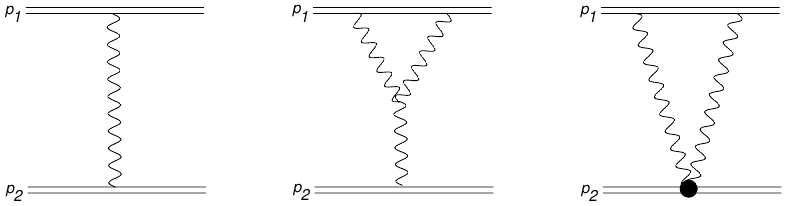
Figure 5 . Diagrams contributing to (next-to-)eikonal phase up to 2PM. Since the strict Regge limit s → ∞ is considered, the hard particles do not recoil and the direction of each Wilson line is specified by the initial momenta. Therefore, no dashed line is necessary and the integration over the position of the GWL vertices runs from −∞ to + ∞